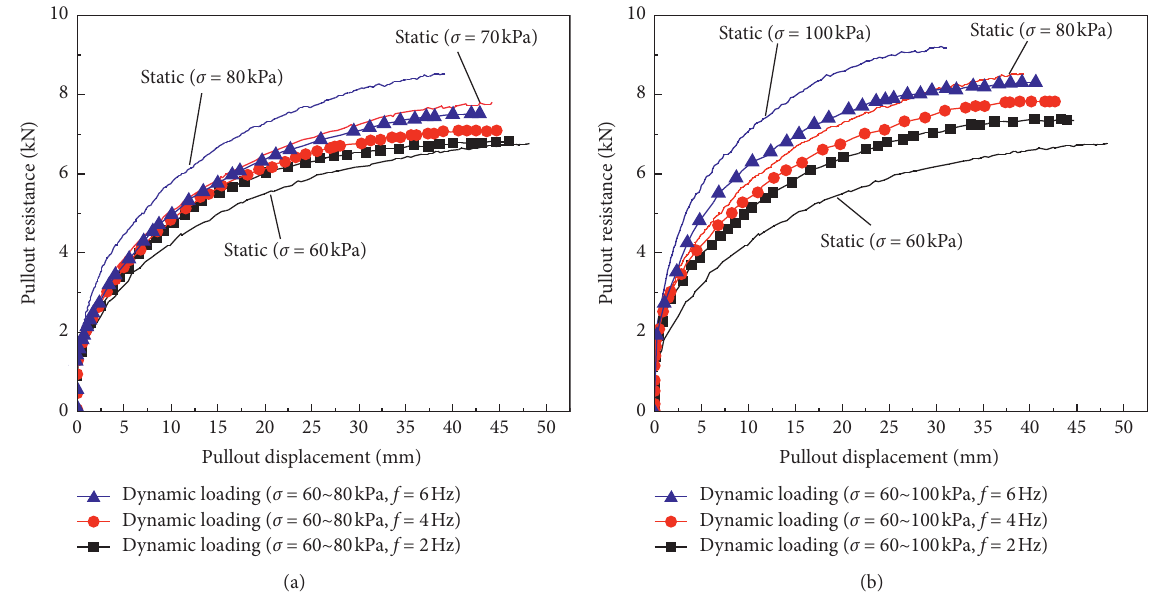
Figure 13: Effect of frequency and loading condition on the pullout resistance: (a) σ � 60 ∼ 80kPa; (b) σ � 60 ∼ 100kPa.